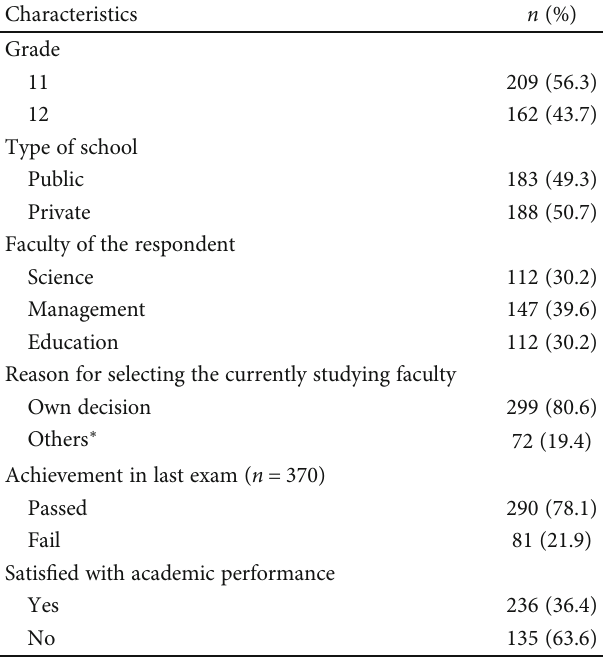
Table 3: Educational characteristics of the respondents ( n = 371 ). Characteristics